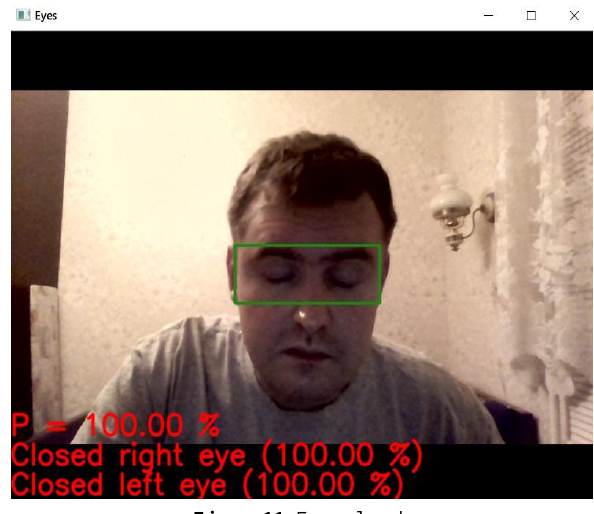
Figure 11 . Eyes closed